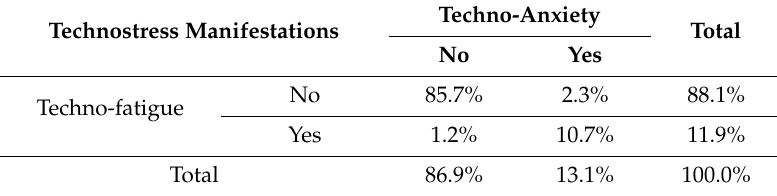
Table 1. Cross between techno-fatigue and techno-anxiety.